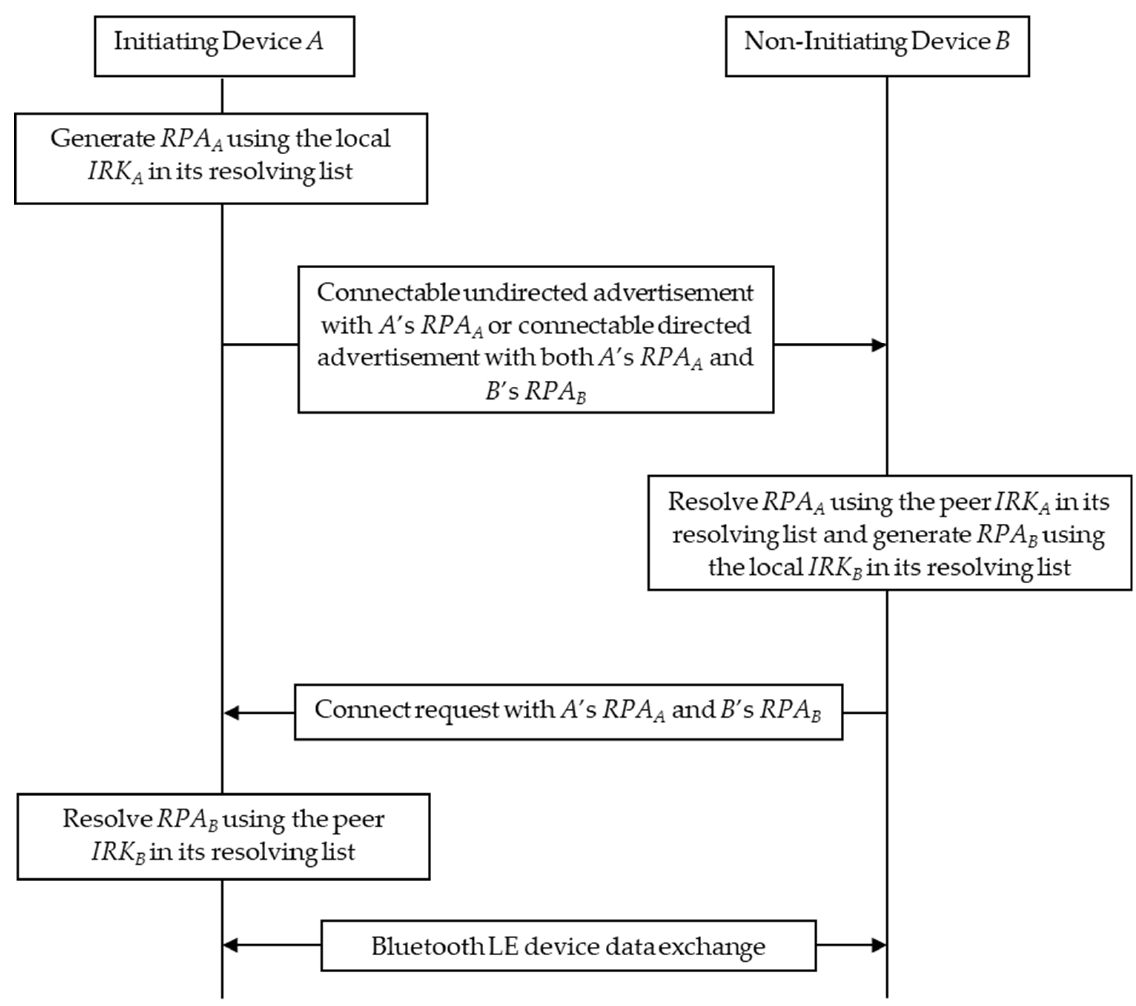
Figure 5. Reconnection procedure using RPA.